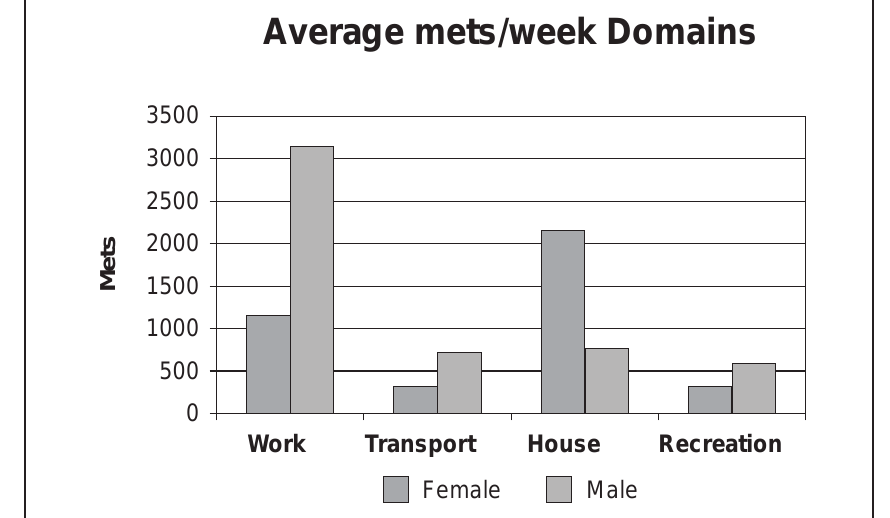
Figure 1: Average METs per week in the four different